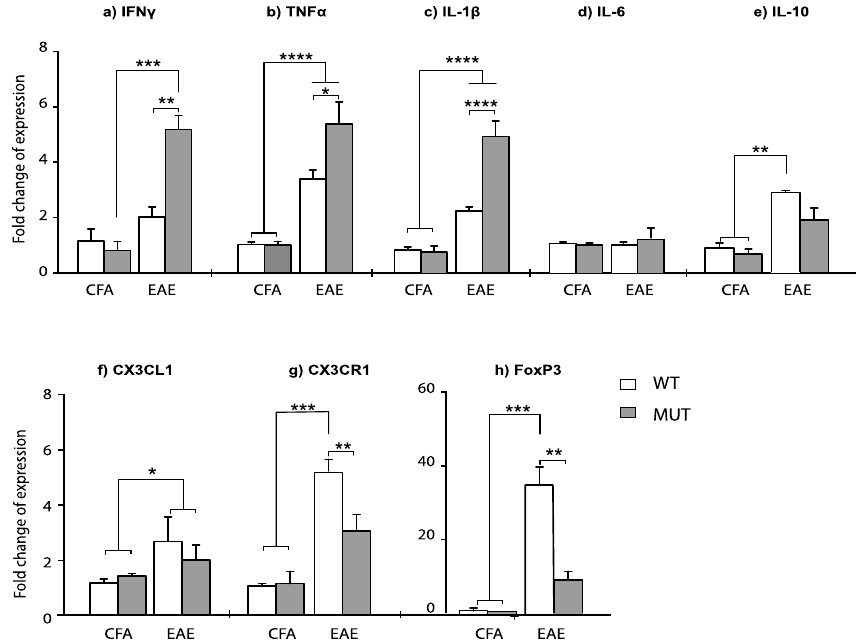
Figure 8. Gene expression of cytokines and immune mediators in spinal cords at chronic EAE. At 30 dpi, lumbar spinal cords were obtained from CFA and EAE mice in order to isolate mRNA and to analyze the levels of expression of the following: ( a ) IFNγ, ( b ) TNFα, ( c ) IL-1β, ( d ) IL-6, ( e ) IL-10, ( f ) CX3CL1, (g) CX3CR1 and ( h ) FoxP3, by Real Time RT-PCR. Graphs show the fold change of expression calculated as 2 −ΔΔCT . GAPDH was used as the housekeeping gene for all cases. In spinal cords from MUT-EAE, relative gene expression of IFNγ, TNFα, and IL-1β ( a – c ) were significantly higher compared to WT-EAE. IL-10 expression ( e ) was upregulated in WT-EAE mice compared to both, WT-CFA and MUT-CFA groups. CX3CR1 and FoxP3 gene expression ( g,h ) were significantly lower in MUT-EAE mice compared to WT-EAE; in fact, no upregulation was observed in MUT-EAE compared to CFA groups. All values are presented as media ± SEM. Two-way ANOVA and Tukey post hoc test. *p < 0.05; **p < 0.001 ***p < 0.0001. WT-CFA n = 5; MUT-CFA n = 5; WT-EAE n = 6; MUT-EAE n =